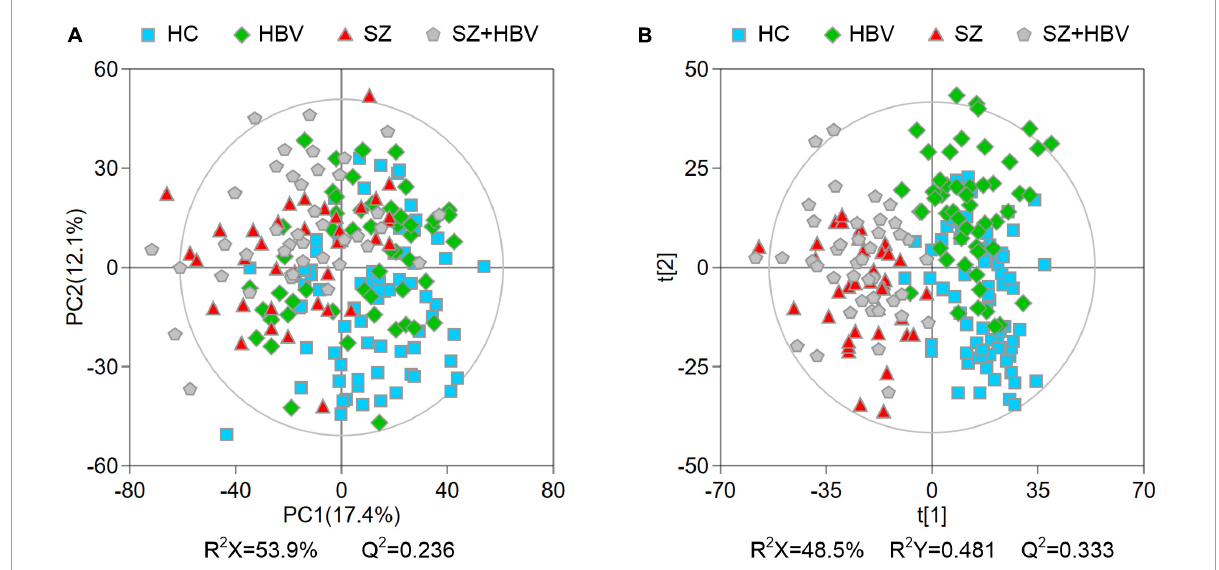
FIGURE2 Principal component analysis (PCA) (A) and partial least-squares discriminant analysis (PLS-DA) (B) score plots of metabolic profiles in different groups. The outer ellipse represents the 95% confidence interval (Hotelling score).